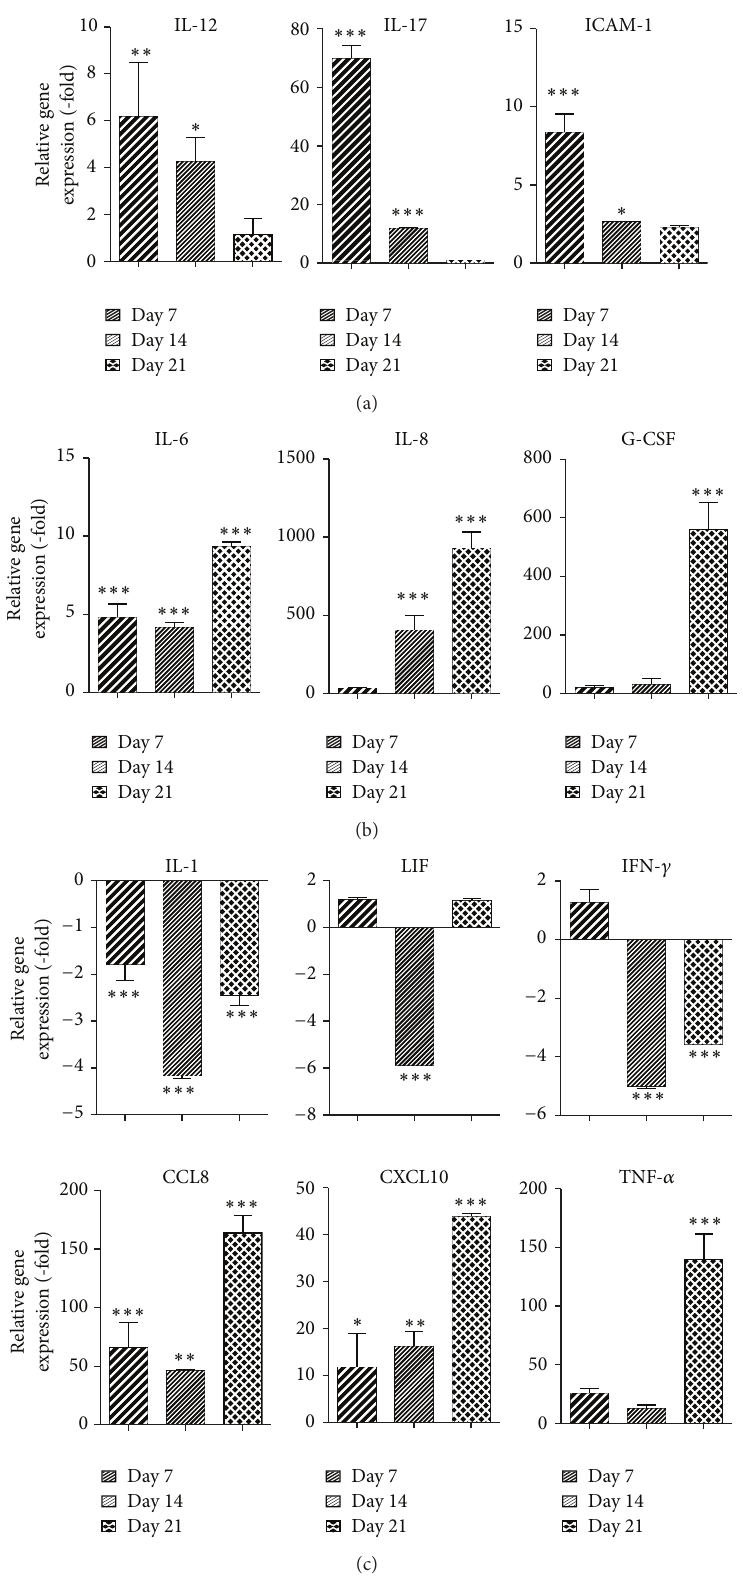
Figure 4: Levels of mRNA expression of proinflammatory cytokines are upregulated during adipogenic differentiation of ASCs. ASCs were grown in CCM and changed to ADM. Cells were harvested on days 7, 14, and 21 and analyzed by qRT-PCR. Data is normalized to undifferentiated cells. Mean ± SEM. ∗ 𝑃 < 0.05 ; ∗∗ 𝑃 < 0.01 ; ∗∗∗ 𝑃 < 0.001 relative to undifferentiated